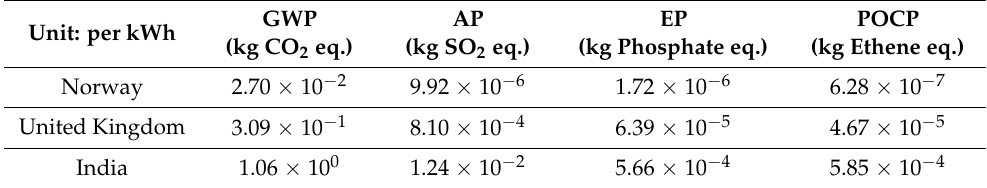
Table 10. Functional units of electricity produced in other sample countries. Unit: per kWh